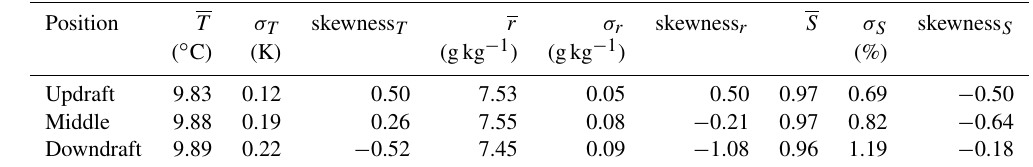
Table 1. The statistics for r , T , and S at each position along the traverse during moist conditions and (cid:49)T = 12K.